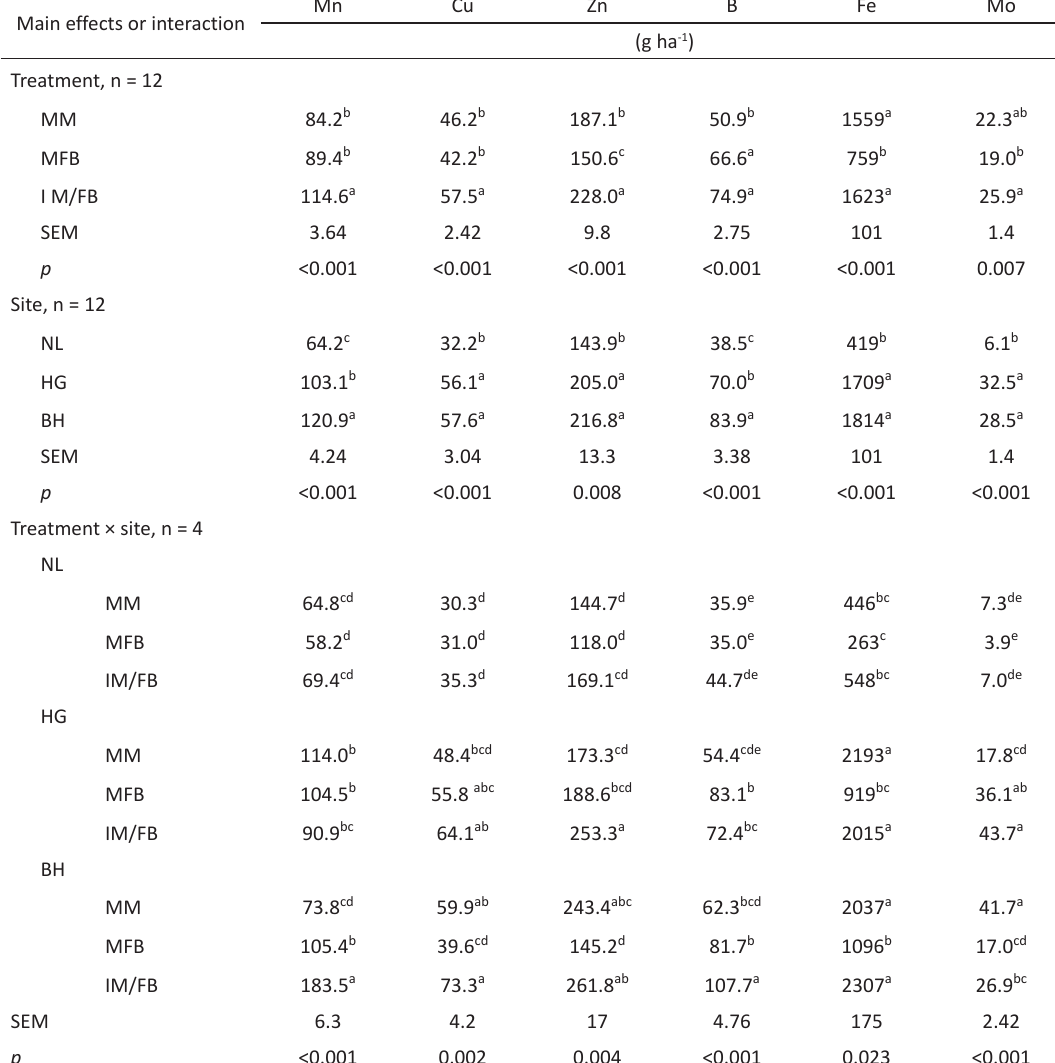
Table 8. Yield of micro nutrients in monocropped and intercropped maize and faba bean in three field experiments Main effects or